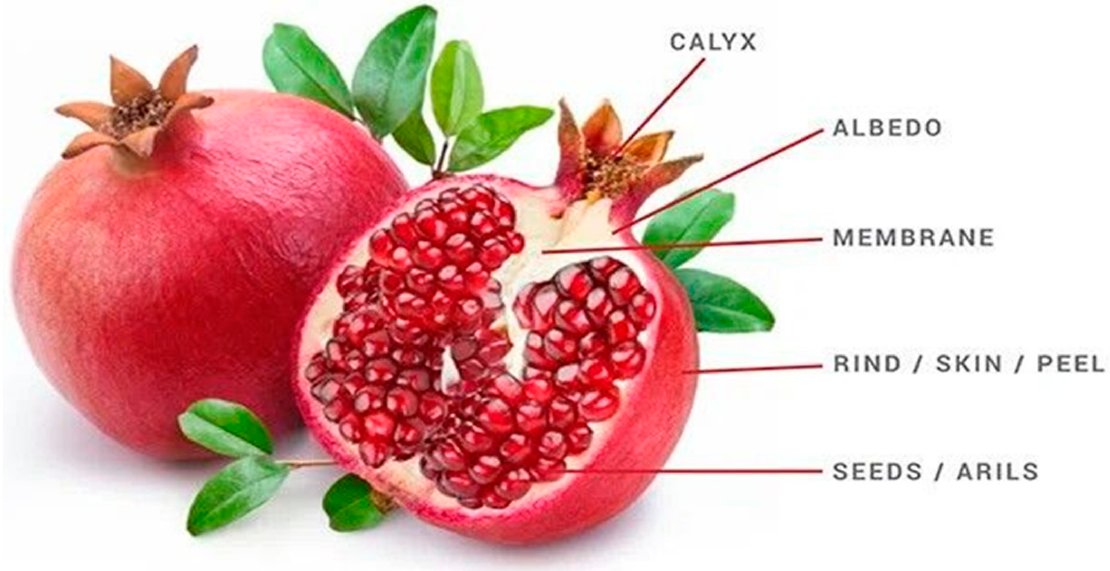
Figure 1. Pomegranate fruit parts.